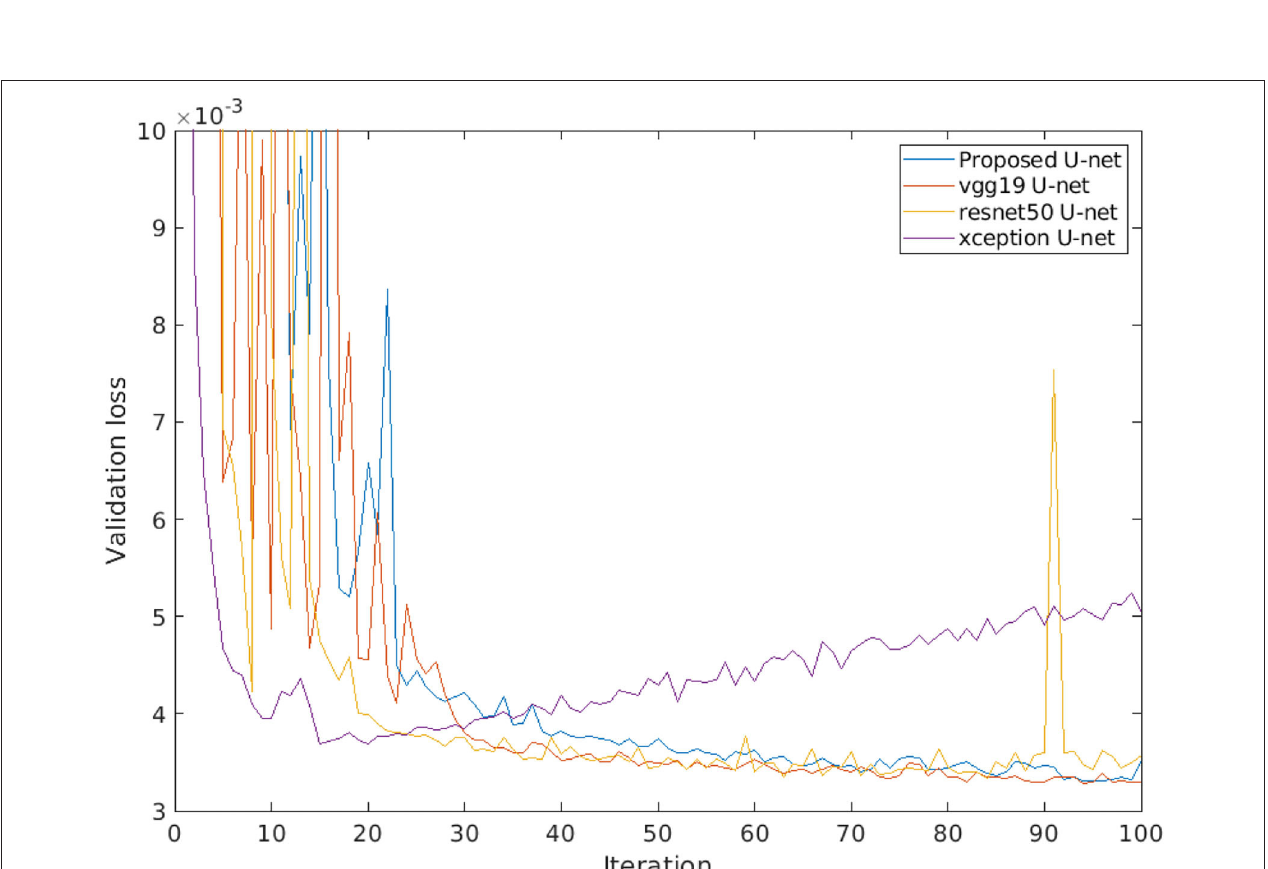
FIGURE 11 | Loss performance of alternative U-net models with different encoder backbones on arabidopsis top view images.